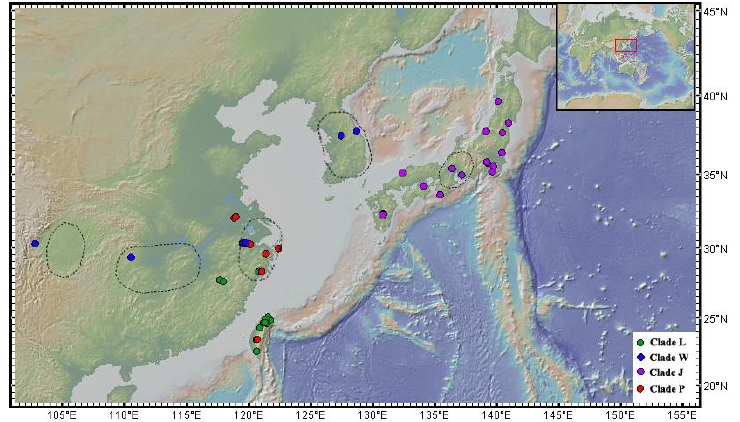
Figure 1. Distribution of Solenysa species. Circles in color represent species of different clades in Figure 2, green, clade L; blue, clade W; purple, clade J, red, clade P. Dash line circles indicate locations of some supposed Pleistocene ice age refugia in East Asia.